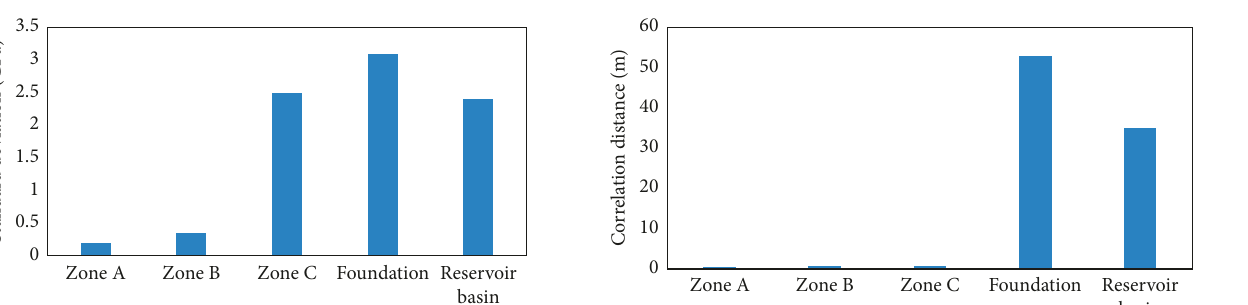
Figure 14: Correlation distance of deformation modulus of dif- ferent